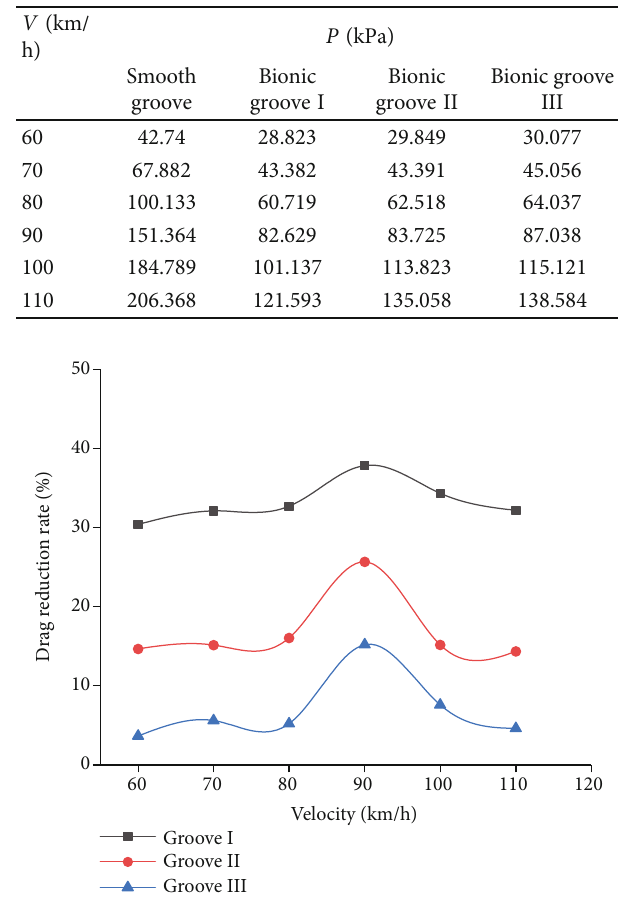
Figure 10: Drag reduction rates of bionic